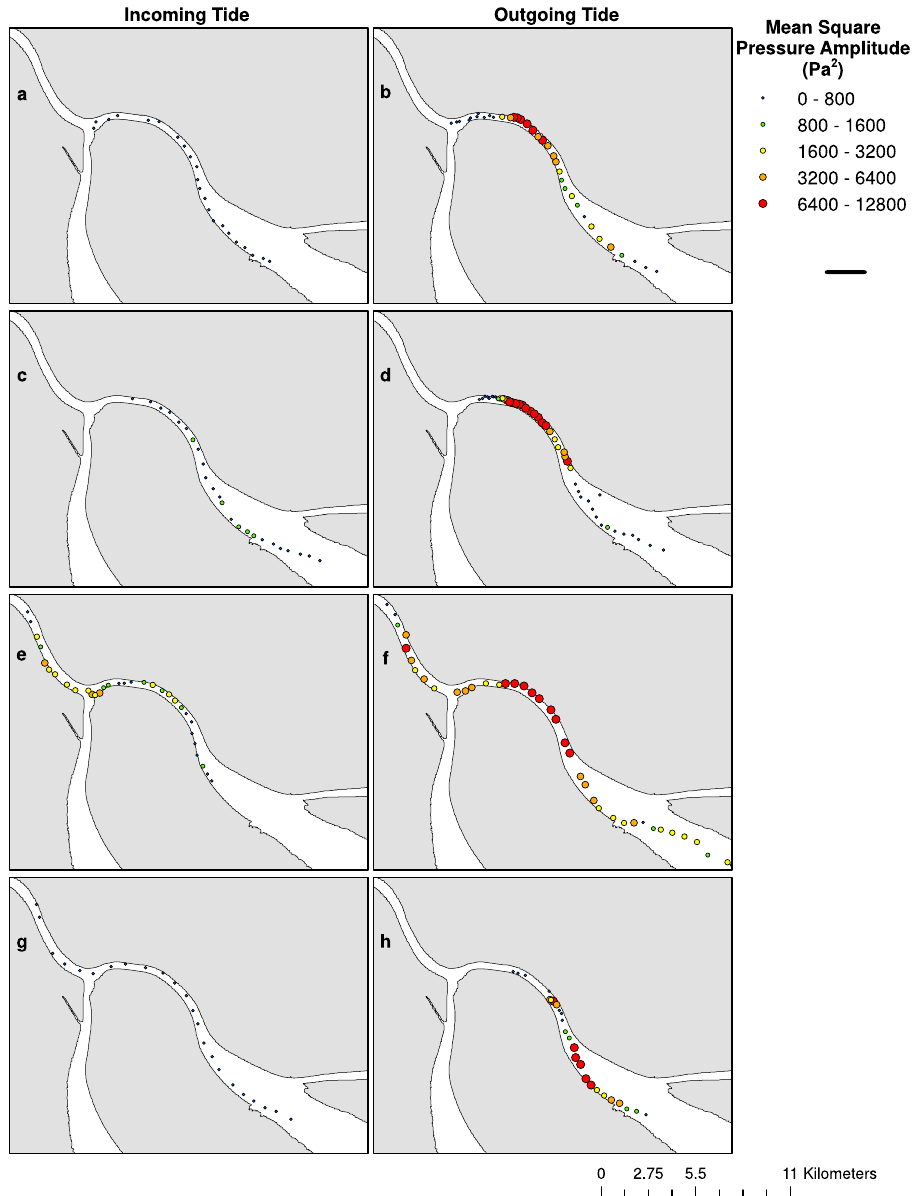
Figure 4. Spatial distribution of mean square pressure amplitude ( p 2 ; Pa 2 ; 251 Hz–498 Hz). Sound levels over the frequency band of Gulf Corvina ( Cynoscion othonopterus) chorusing in the spawning grounds of the northeastern channel of the Colorado River Delta on the incoming and outgoing tides on ( a , b ) 27 March 2014, ( c , d ) 28 March 2014, ( e , f ) 27 April 2014, and ( g , h ) 28 April 2014. Collection of passive acoustic data on the outgoing tide of 27 March 2014 ( b ) continued after the conclusion of the active acoustic survey. Maps were generated using the ArcMap extension of ArcGIS version 10.2.2 (http://www.esri.com/, ESRI,